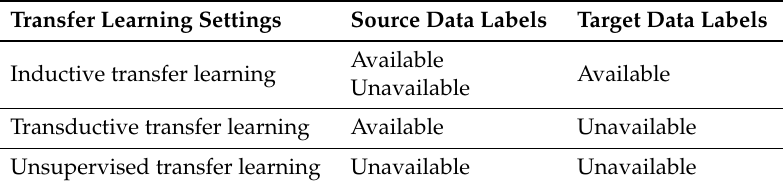
Table 1. Different settings of transfer learning.